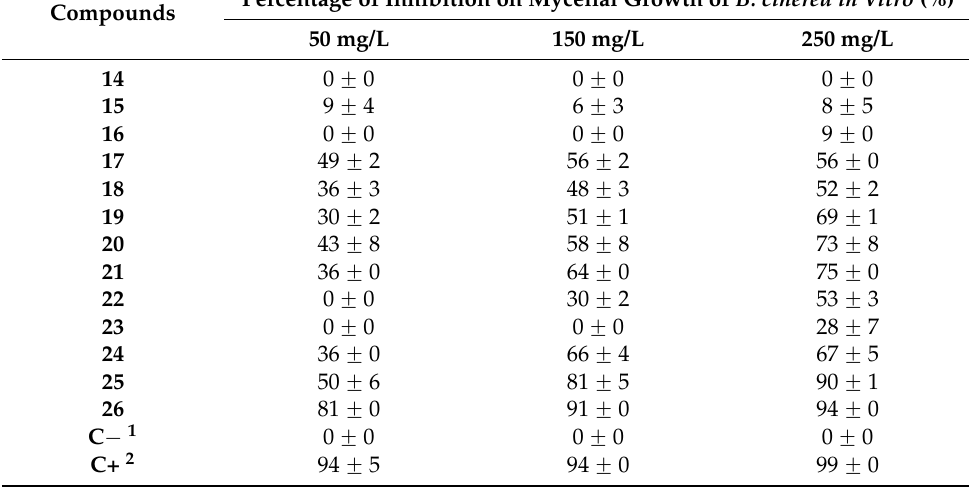
Table 1. Percentage of inhibition of geranylated phenols ( 14 – 18 ), geranylated quinones ( 19 – 21 ) and hydrated geranylphenols ( 22 – 26 ) on the mycelial growth of B. cinerea strain GM7 at 72 h in vitro .